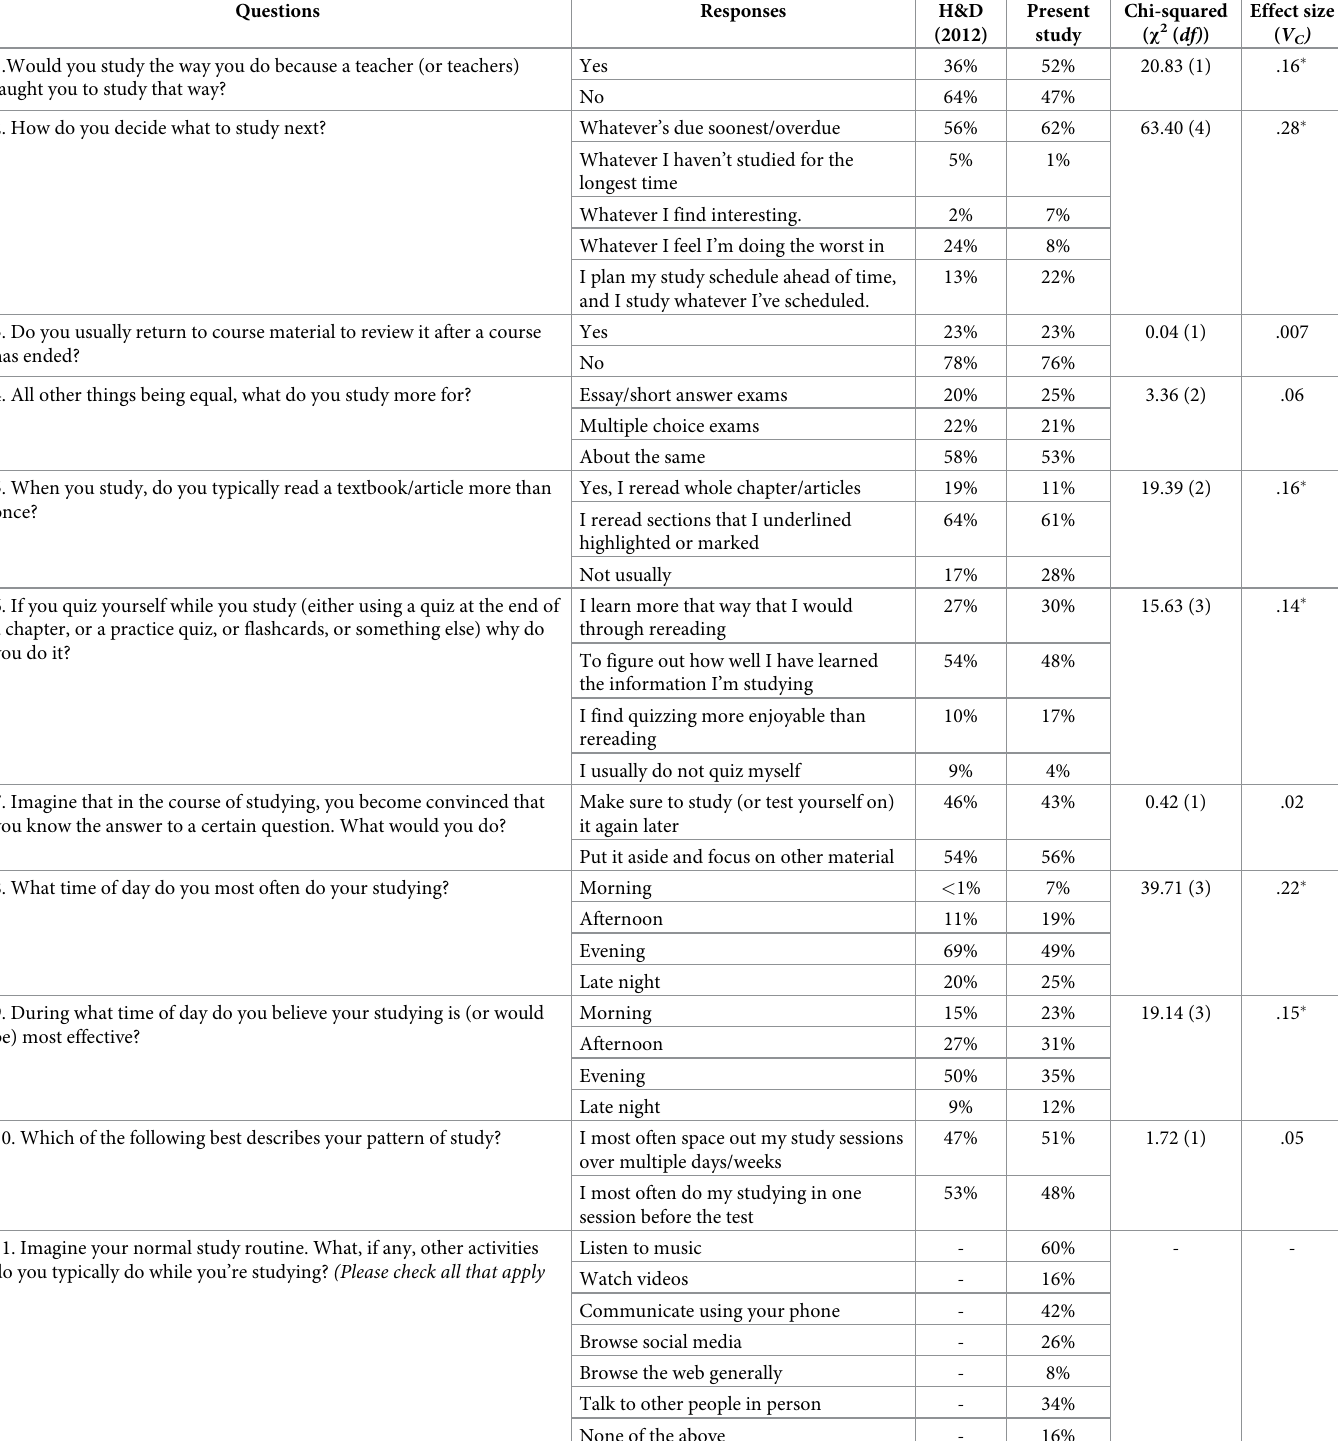
Table 1. Questionnaire response proportions for Hartwig and Dunlosky (2012), the current study, and chi-squared comparisons between the two